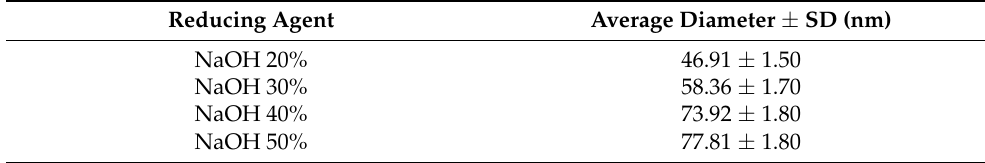
Table 3. Diameter size of AgNPs-chi-spheres.